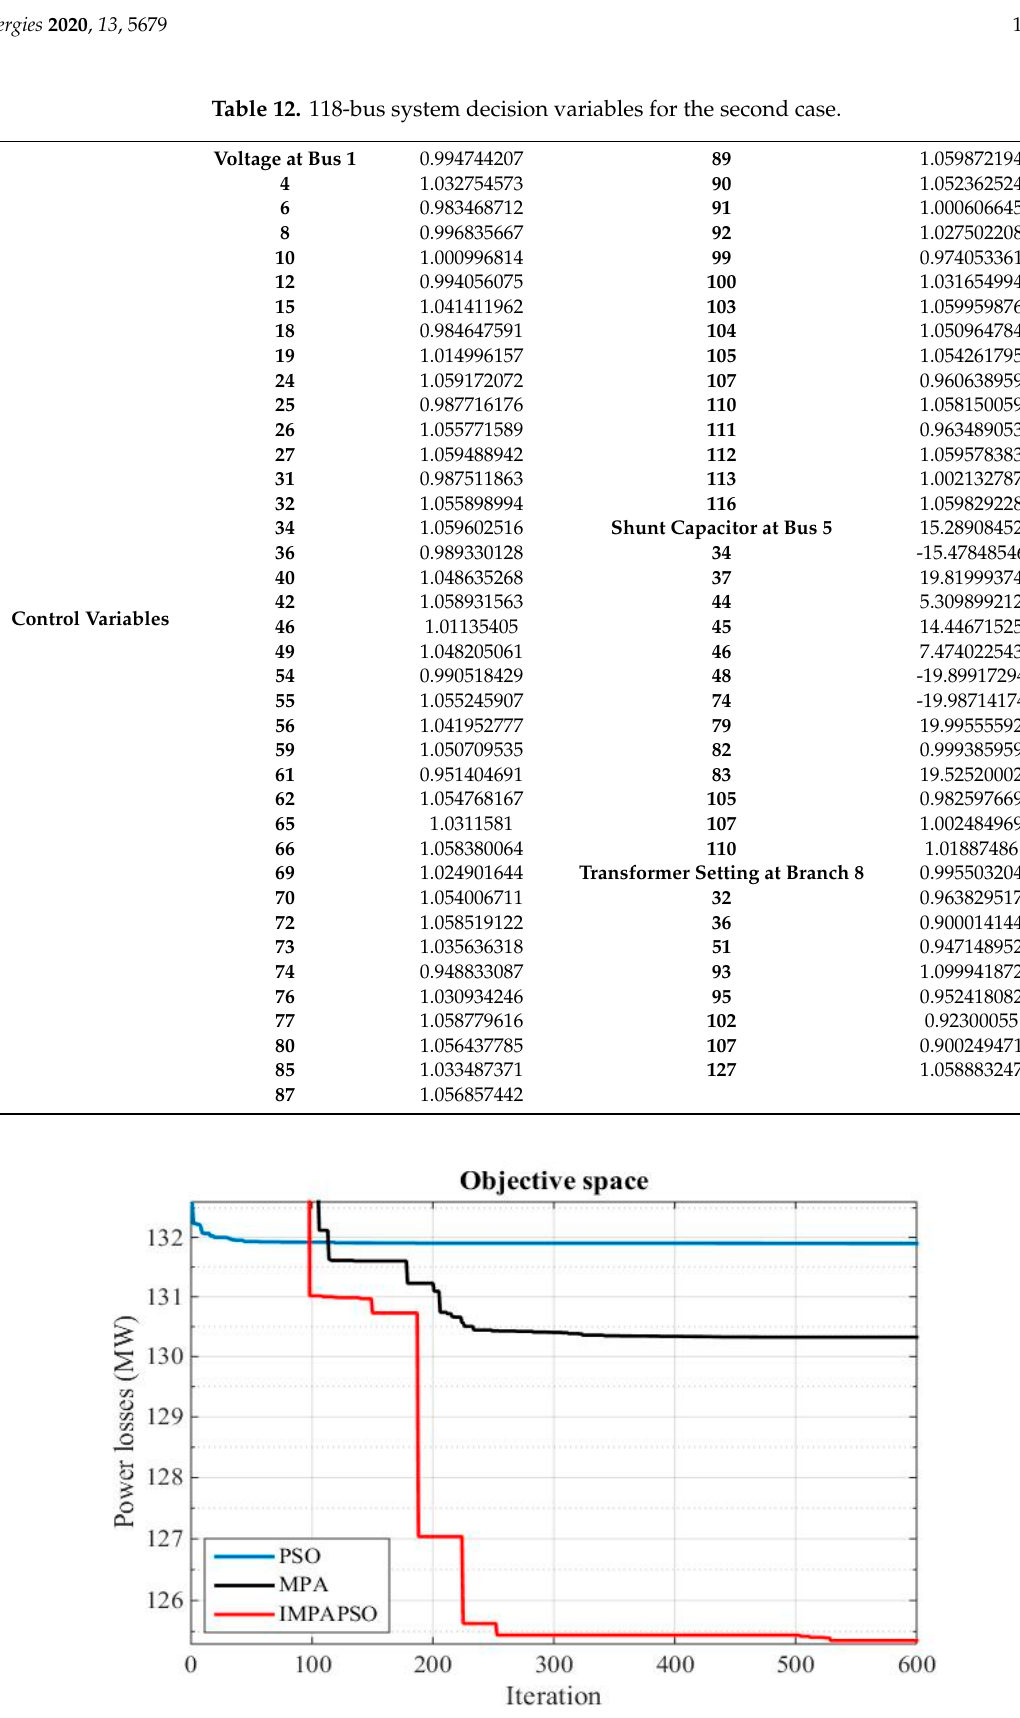
Figure 11. Convergence of PSO, MPA, and IMPAPSO in the first case of the IEEE 118-bus system.